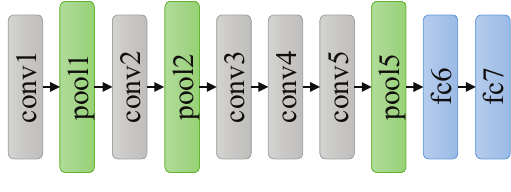
Figure 4. The architecture of AlexNet.